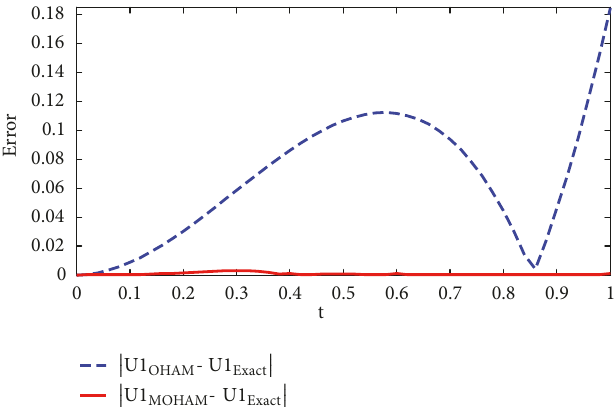
Figure 7: Absolute errors of OHAM and MOHAM for u1 in Example 2.